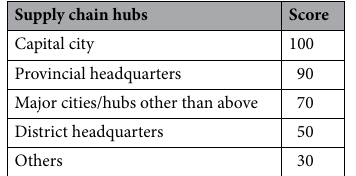
Table 8. Score of the major hub for the supply chain